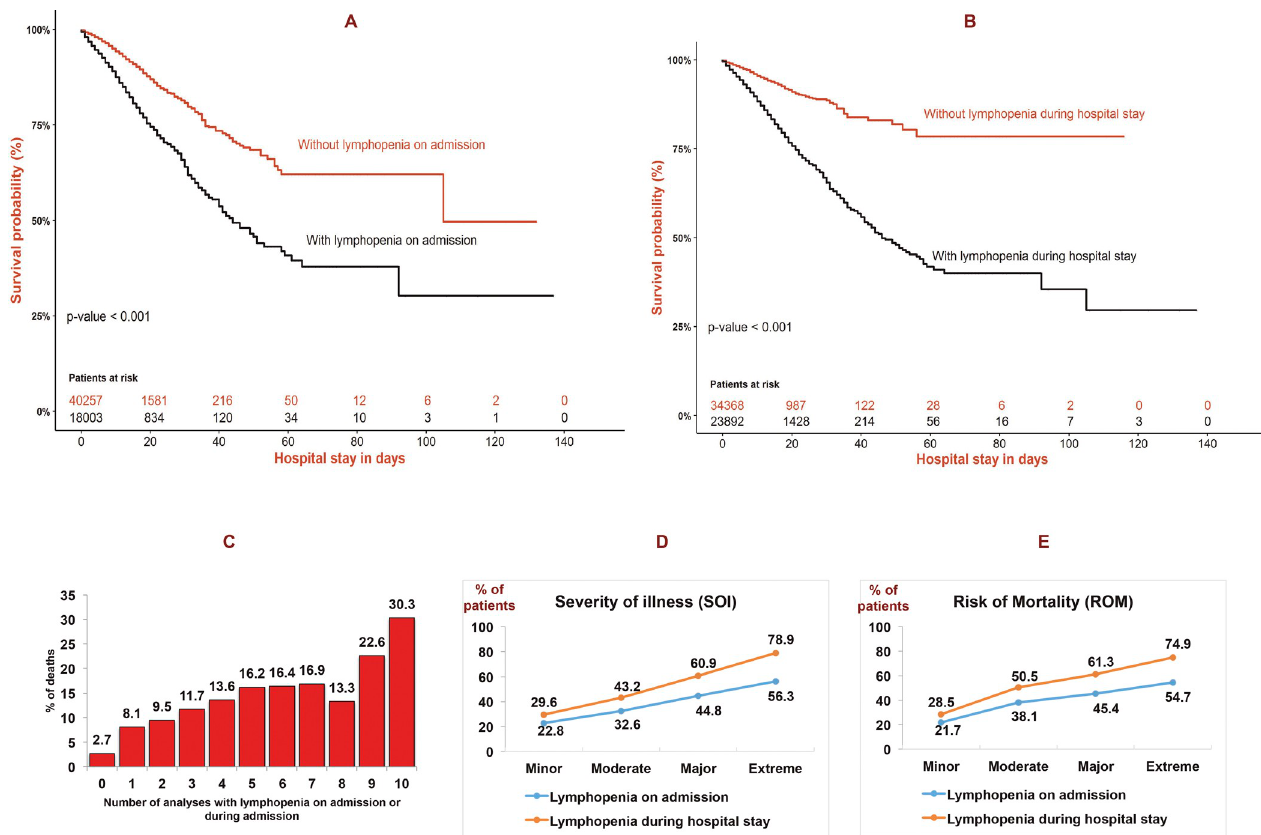
Fig 2. Kaplan-Meier plots illustrating Survival probability following lymphopenia on admission (A) and lymphopenia during hospital stay (B) in peripheral blood of admitted patients. Time is expressed in days (mean). Log-Rank test ( p -value). Percentage of dead patients according to the number of analyzes performed with lymphopenia on admission or during admission (C) . Percentage of patients with lymphopenia on admission and during hospital stay according to four subclases of Severity of illness (SOI) (D) and Risk of Mortality (ROM) (E) . Chi square Pearson test, p < 0.001. Pearson’s R: Interval-by- interval, p < 0.001. Spearman correlation: Ordinal-by-ordinal, p < 0.001 (D and E panels).